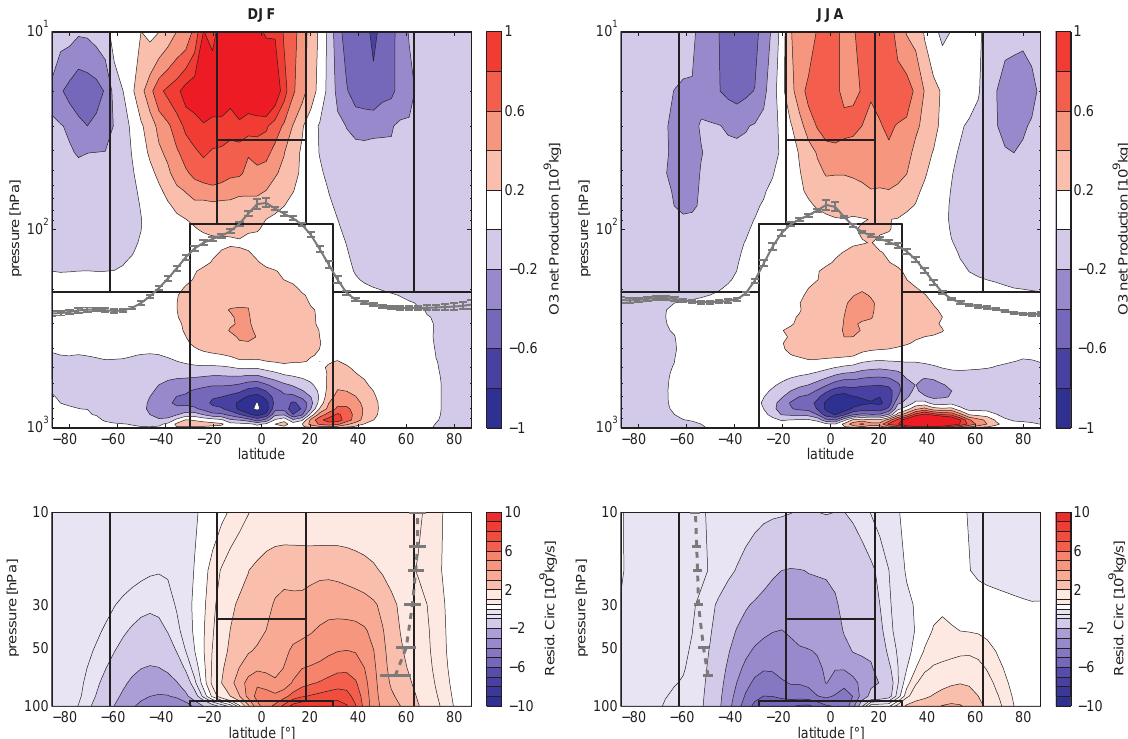
Fig. 3. Top: climatology (2000–2009) of the net ozone production in kg per gridbox and over the three-month period DJF (left) and JJA (right). The grey solid line is the mean position of the dynamical tropopause. Bottom: climatology of the mass-weighted streamfunction of the residual circulation in the stratosphere. The grey dashed line is the location of the winter hemisphere jet (latitude of maximal zonal wind speed). The vertical and horizontal bars denote the inter-annual variability as 1 σ .